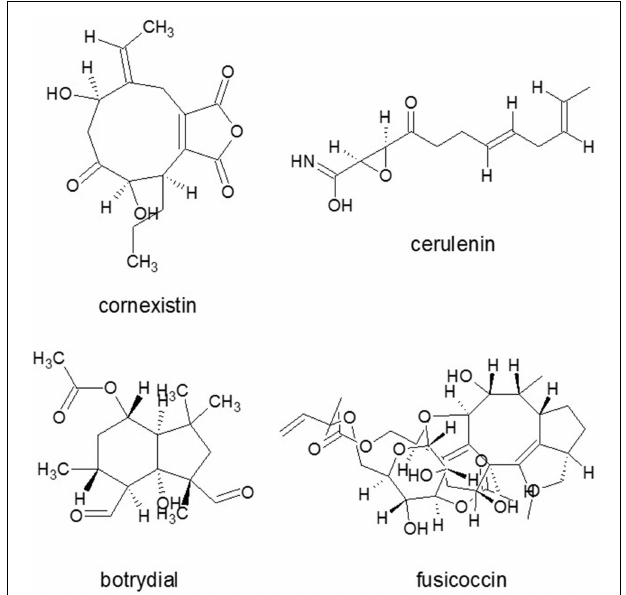
FIGURE 5 | Phytotoxic SM molecules from diverse fungi. Cornexistin from Paecilomyces variotii , fusicoccin from Fusicoccum ( Phomopsis ) amygdali , cerulenin Cephalosporium caerulens and botrydial from Botrytis cinerea .Source: National Center for Biotechnology Information. PubChem Compound Database (accessed Jun. 6, 2015) (Bolton et al.,